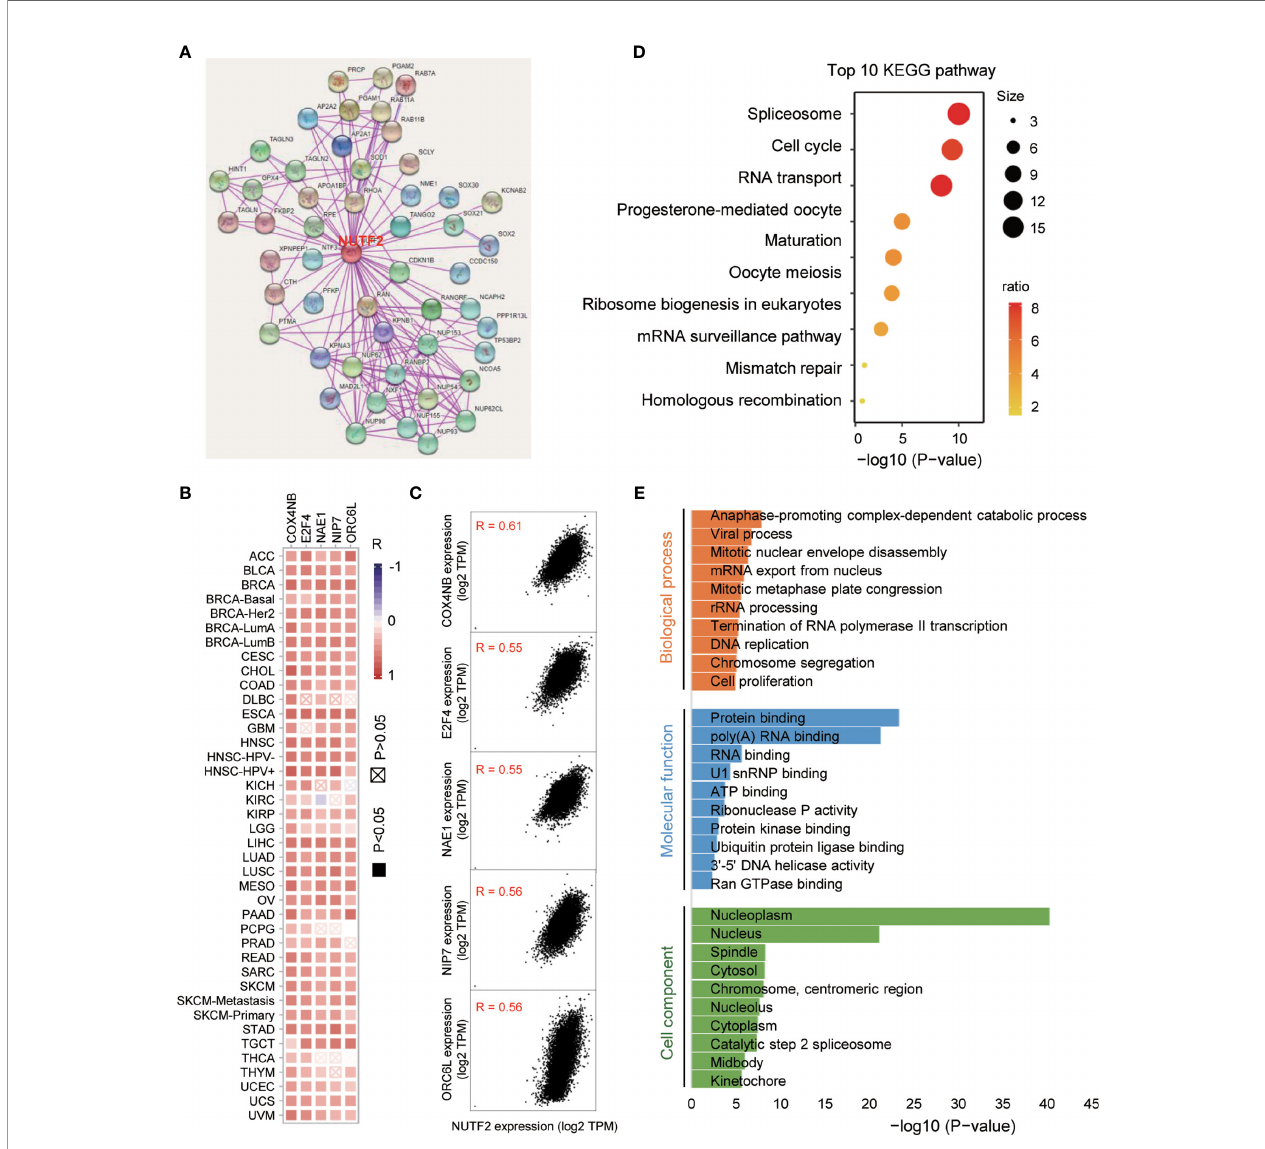
FIGURE 6 | Enrichment analysis of NUTF2 co-expression genes. (A) Protein – protein interaction network was analyzed via the STRING online resource. (B) The heat map of correlation between NUTF2 and the top 5 genes in different cancer types. (C) Correlation of the top 5 genes and NUTF2 in all the cancer samples. (D) KEGG pathway analysis of the top 200 genes that associated with NUTF2 expression. (E) Gene ontology analysis of the top 200